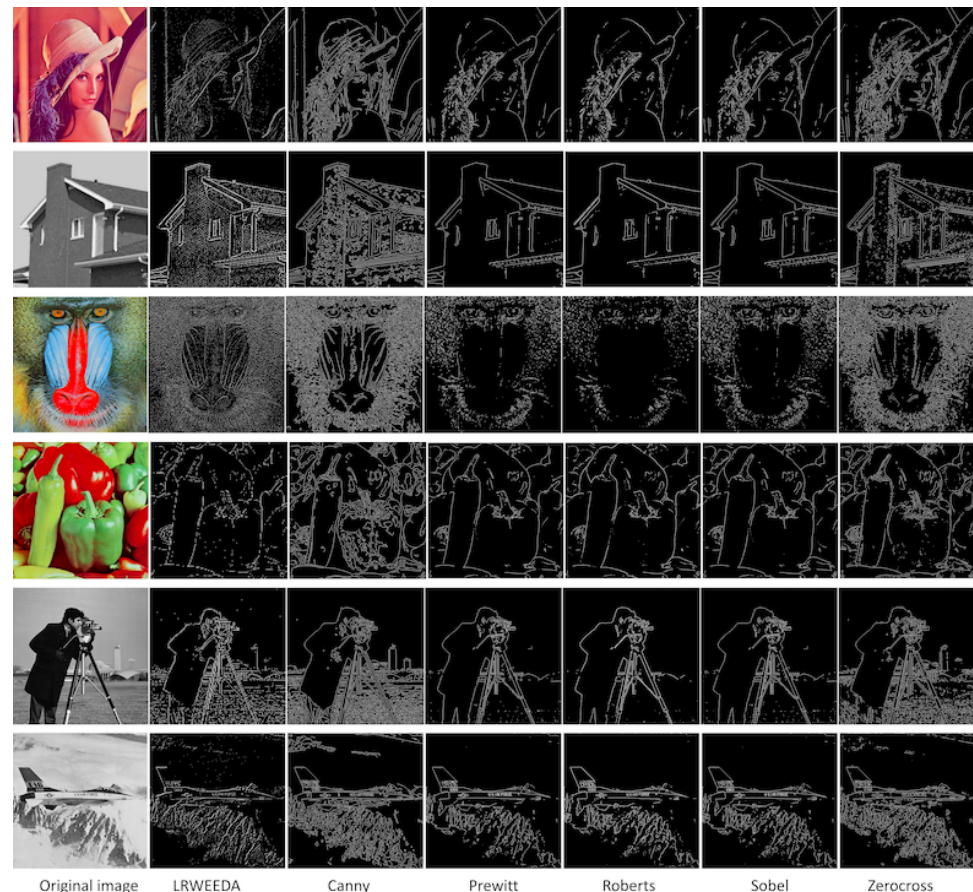
Figure 9. The original image is shown in the first column of the image grid. Other columns correspond to different edge detection algorithms, and the algorithm name is mentioned in the bottom of the column. For the LRWEEDA algorithm, the following parameters were used (from the first row to the last row): (1) “Lena” image: LRWEEDA (output image size of 256 × 256 pixels) using Haar, j = 1, Λ = 0.480; (2) “House” image: LRWEEDA (258 × 258 pixels) using Coiflet, j = 1, Λ = 0.635; (3) “Mandril” image: LRWEEDA (258 × 258 pixels) using Coiflet, j = 1, Λ = 0.520; (4) “Peppers” image: LRWEEDA (131 × 131 pixels) using Coiflet, j = 2, Λ = 0.480; (5) “Cameraman” image: LRWEEDA (131 × 131 pixels) using Coiflet, j = 2, Λ = 0.530; and (6) “Jetplane” image: LRWEEDA (256 × 256 pixels) using Haar, j = 1, Λ =